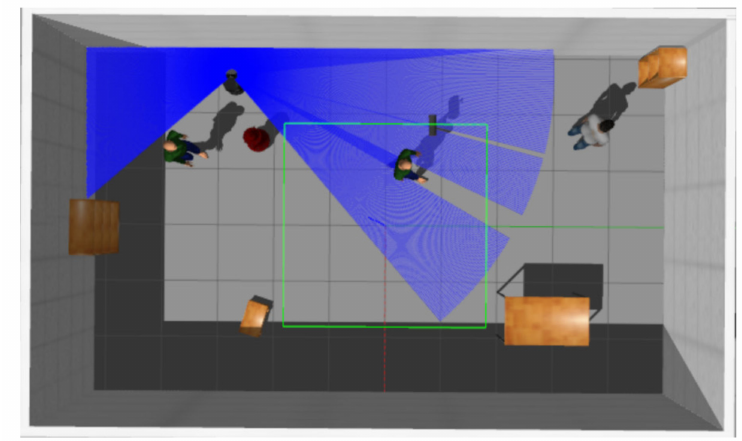
Figure 3. The virtual training